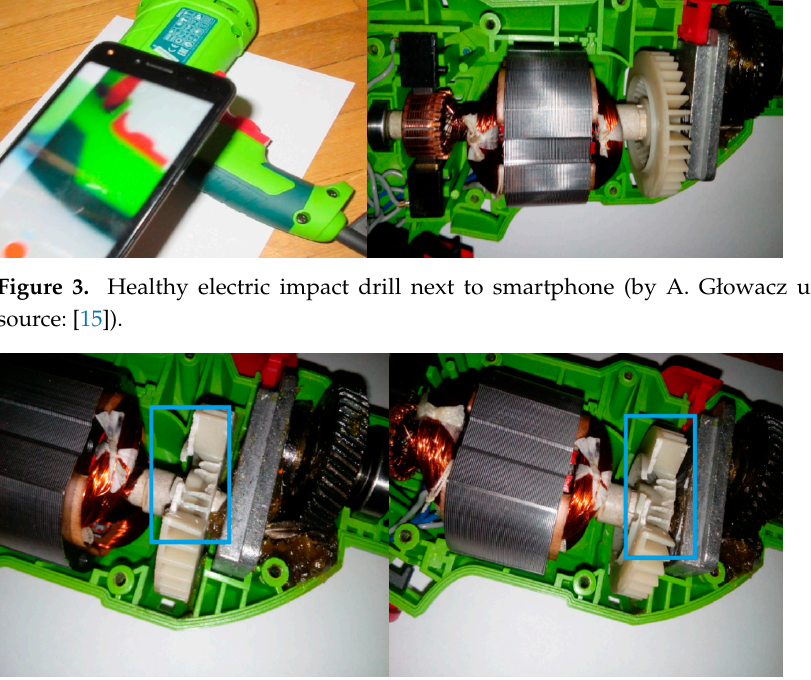
Figure 4. Electric impact drill with a faulty fan (five broken rotor blades, indicated by the blue box). Recordings from similarly damaged drills are used with the functional logistic regression classifiers later in this paper (by A. Głowacz under CC BY 4.0, source: [15]).